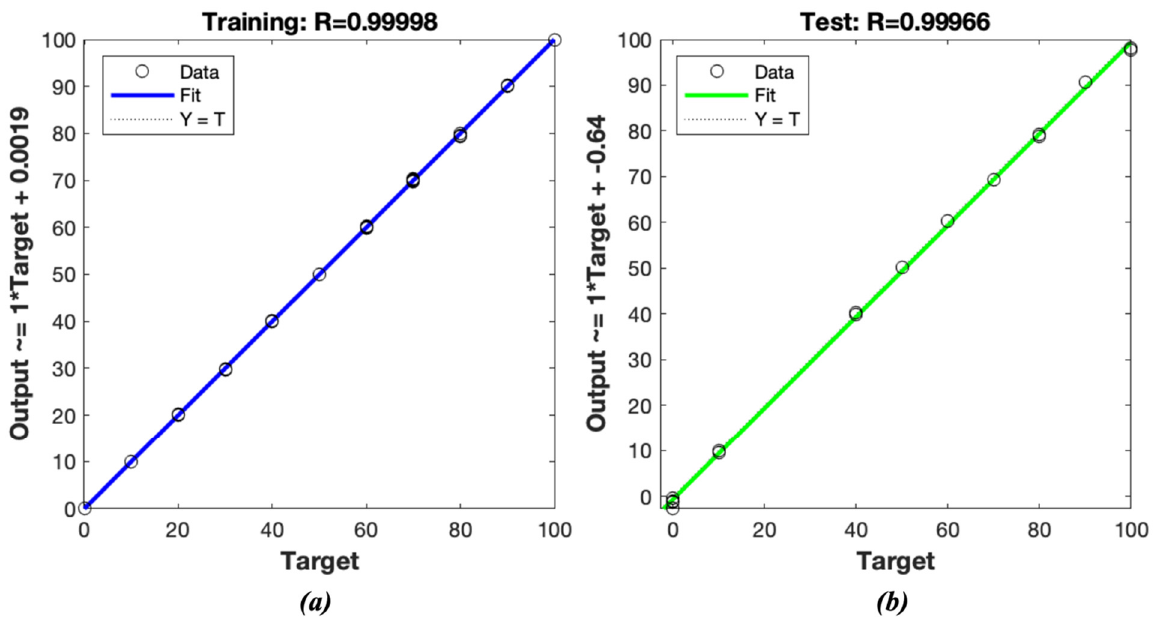
Figure 13. Regression diagrams of the predicted and simulated results for the void fractions: ( a ) training set and ( b ) testing set.